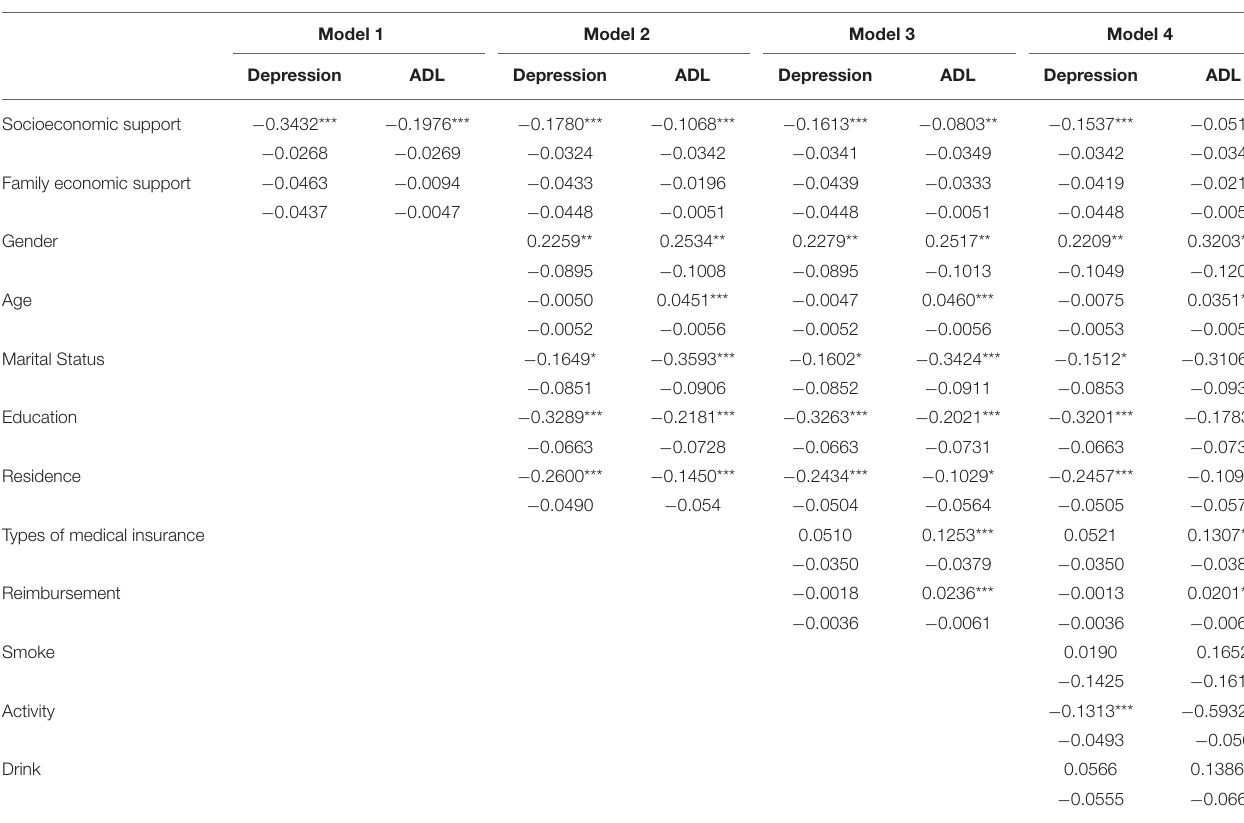
TABLE 4 | Mental health/ADL stepwise regression